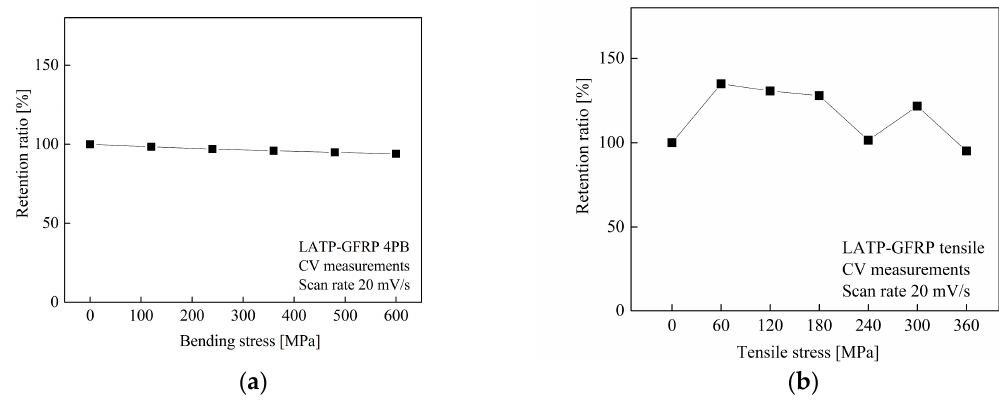
Figure 12. ( a ) LATP–GFRP with four-point bending test (4PB); ( b ) LATP–GFRP with tensile test; Values are averages from 2–3 specimens.